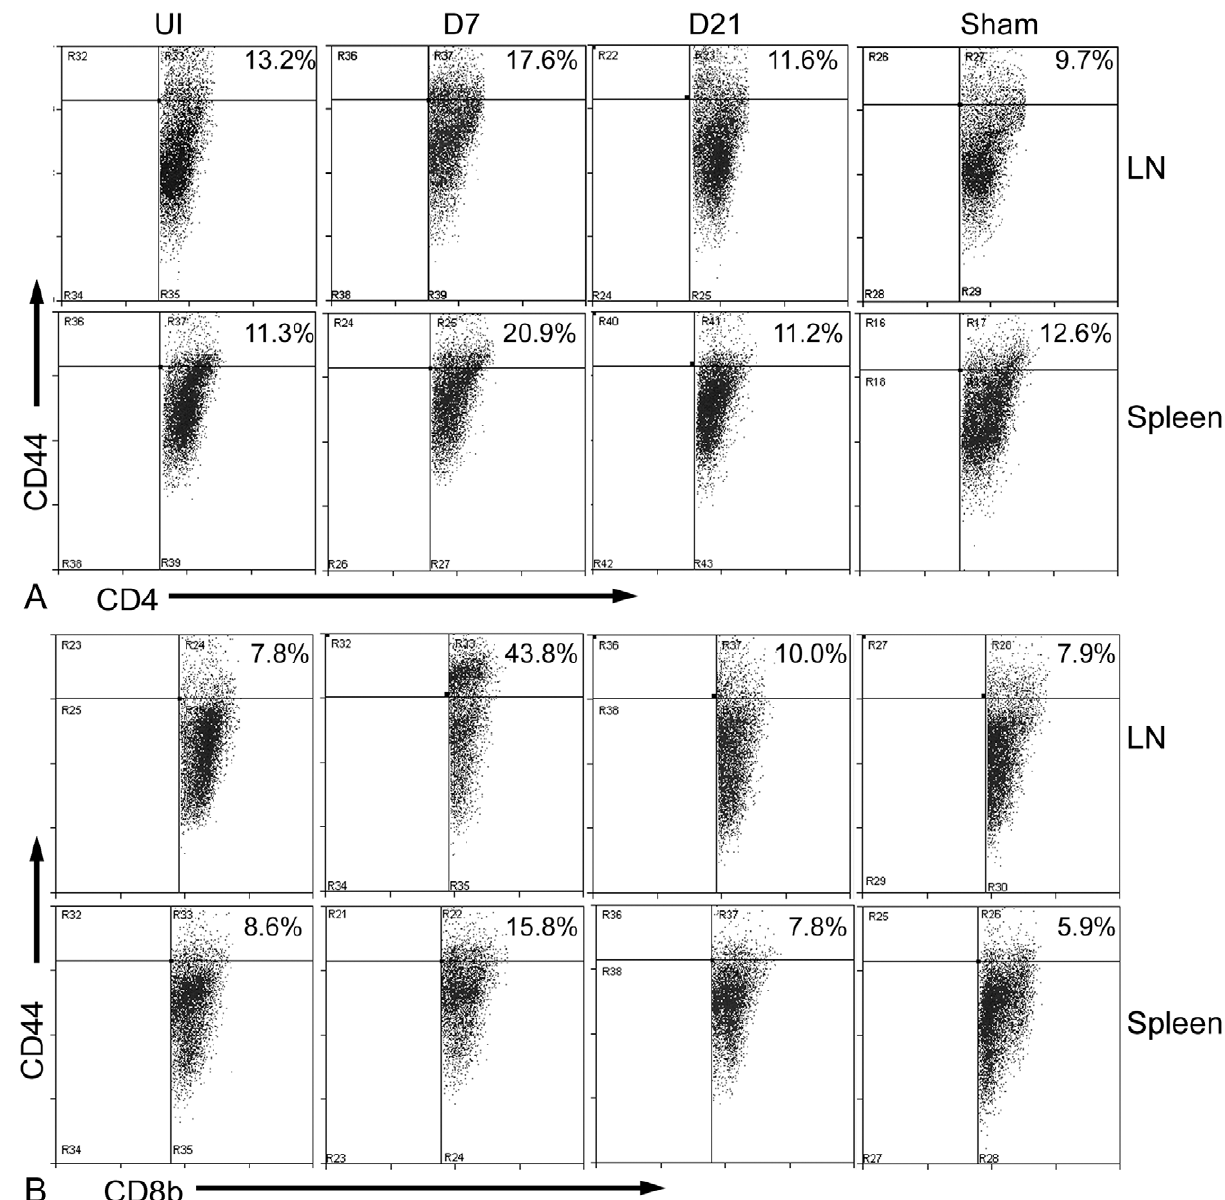
Figure 1. Lymph node and splenic CD44 + T cells after arterial injury in WT mice. Representative scatter plots of lymph node (LN) and spleen cells collected at various times after injury and characterized using CD44 gated on CD4 (A) or CD8b (B). Cells were collected from uninjured (UI) mice, or 7 days (D7) and 21 days (D21) after arterial injury. Sham mice correspond to 7 days after sham surgery. Percentage of cells is indicated on the top right corner of each graph.